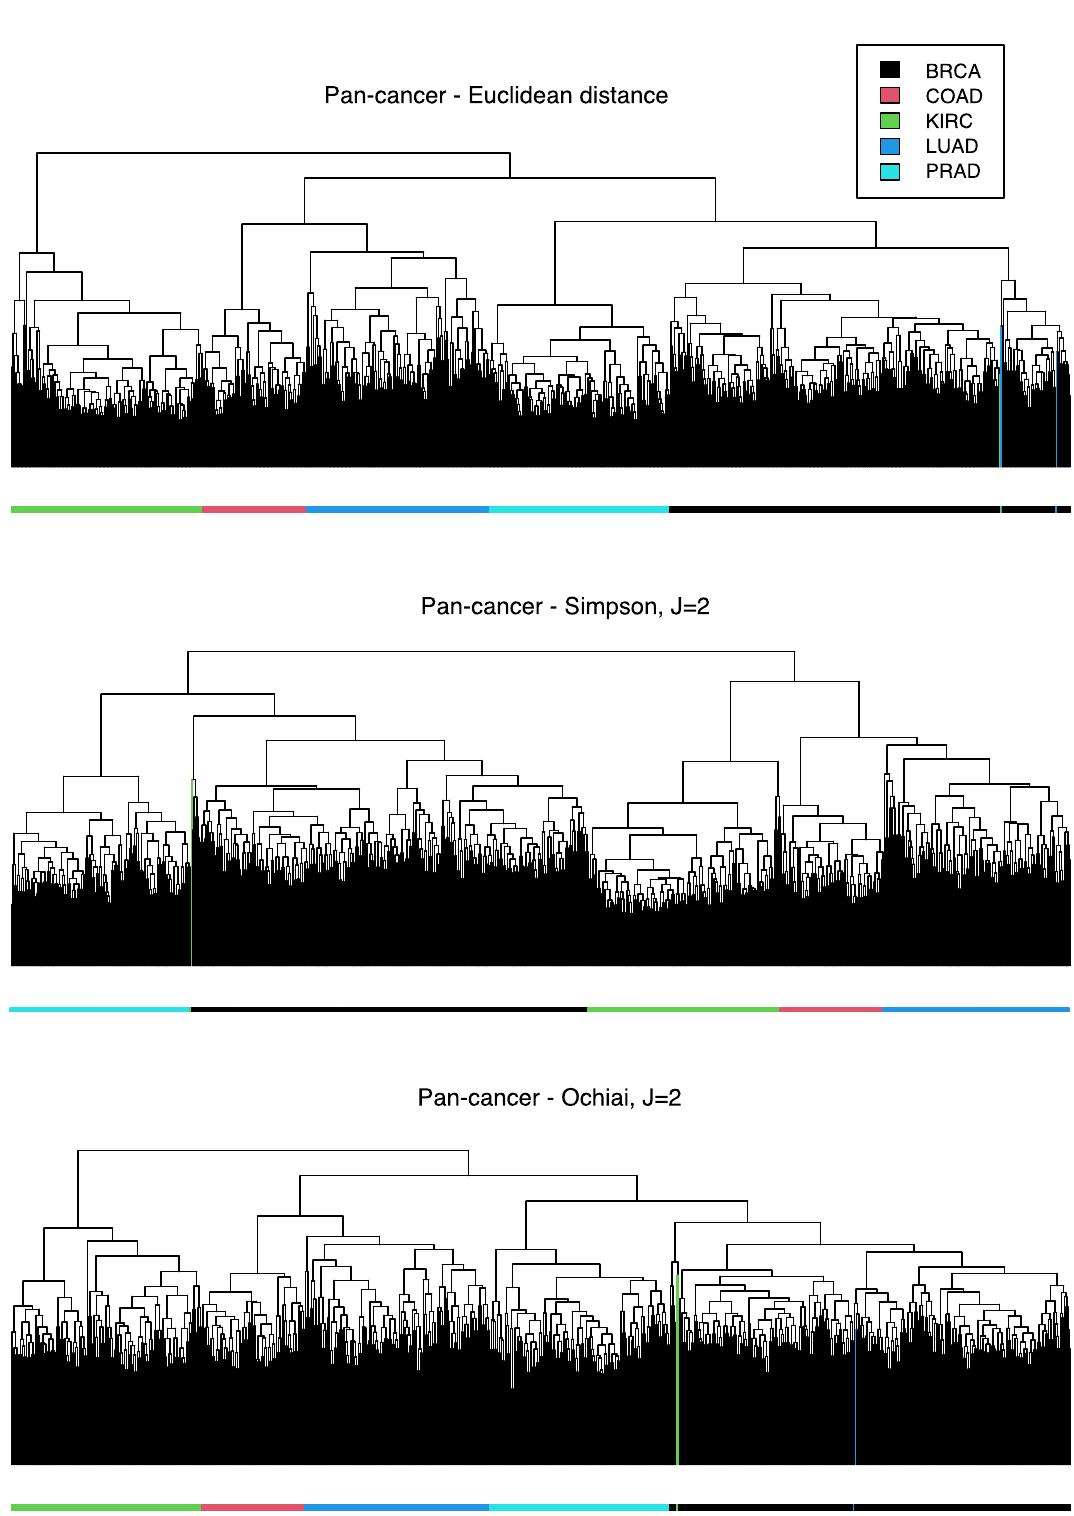
Figure 8. Clustering the Pan-cancer data set. Dendrograms for the Pan-cancer data set, using the Euclidean distance (top), the Simpson (middle) and the Ochiai (bottom) indices, with J = 2 . Wrongly assigned samples are coloured in the